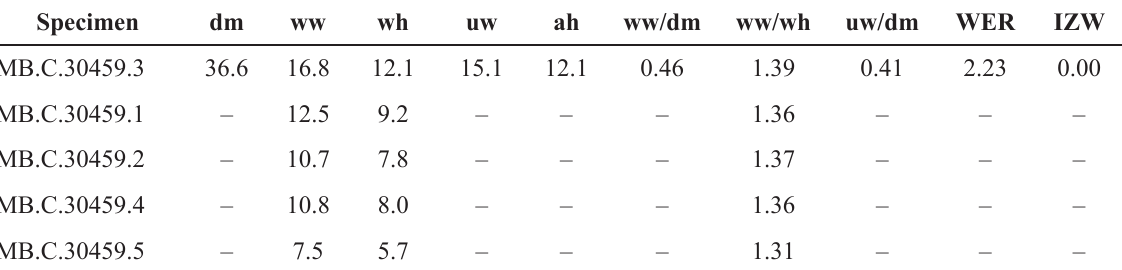
Table 6. Conch dimensions (in mm) and ratios of Stroboceras ancilis sp. nov. Specimen dm ww wh uw ah ww/dm ww/wh uw/dm WER IZW MB.C.30459.3 36.6 MB.C.30459.2 MB.C.30459.4